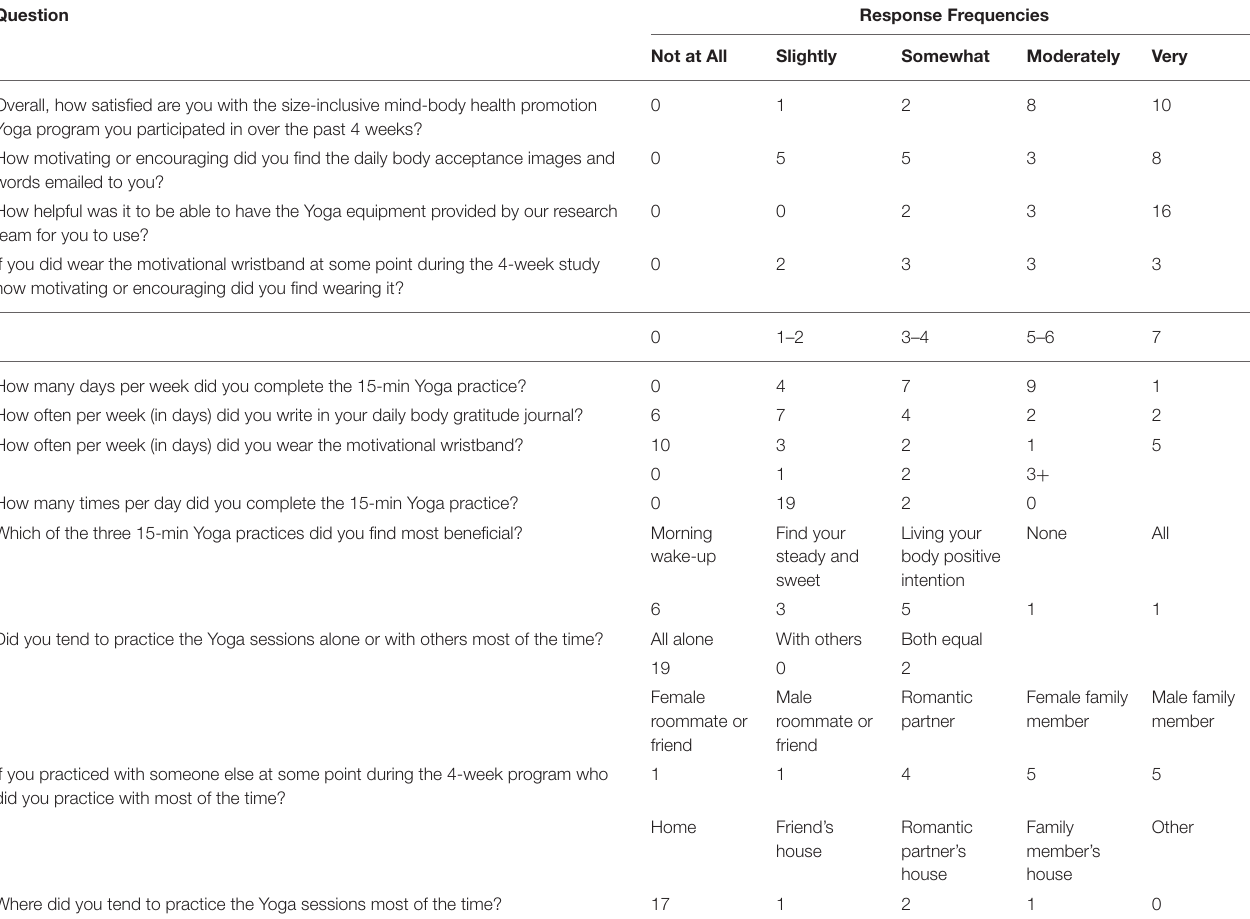
TABLE 2 | Participant responses to feedback questionnaire ( N = 21).